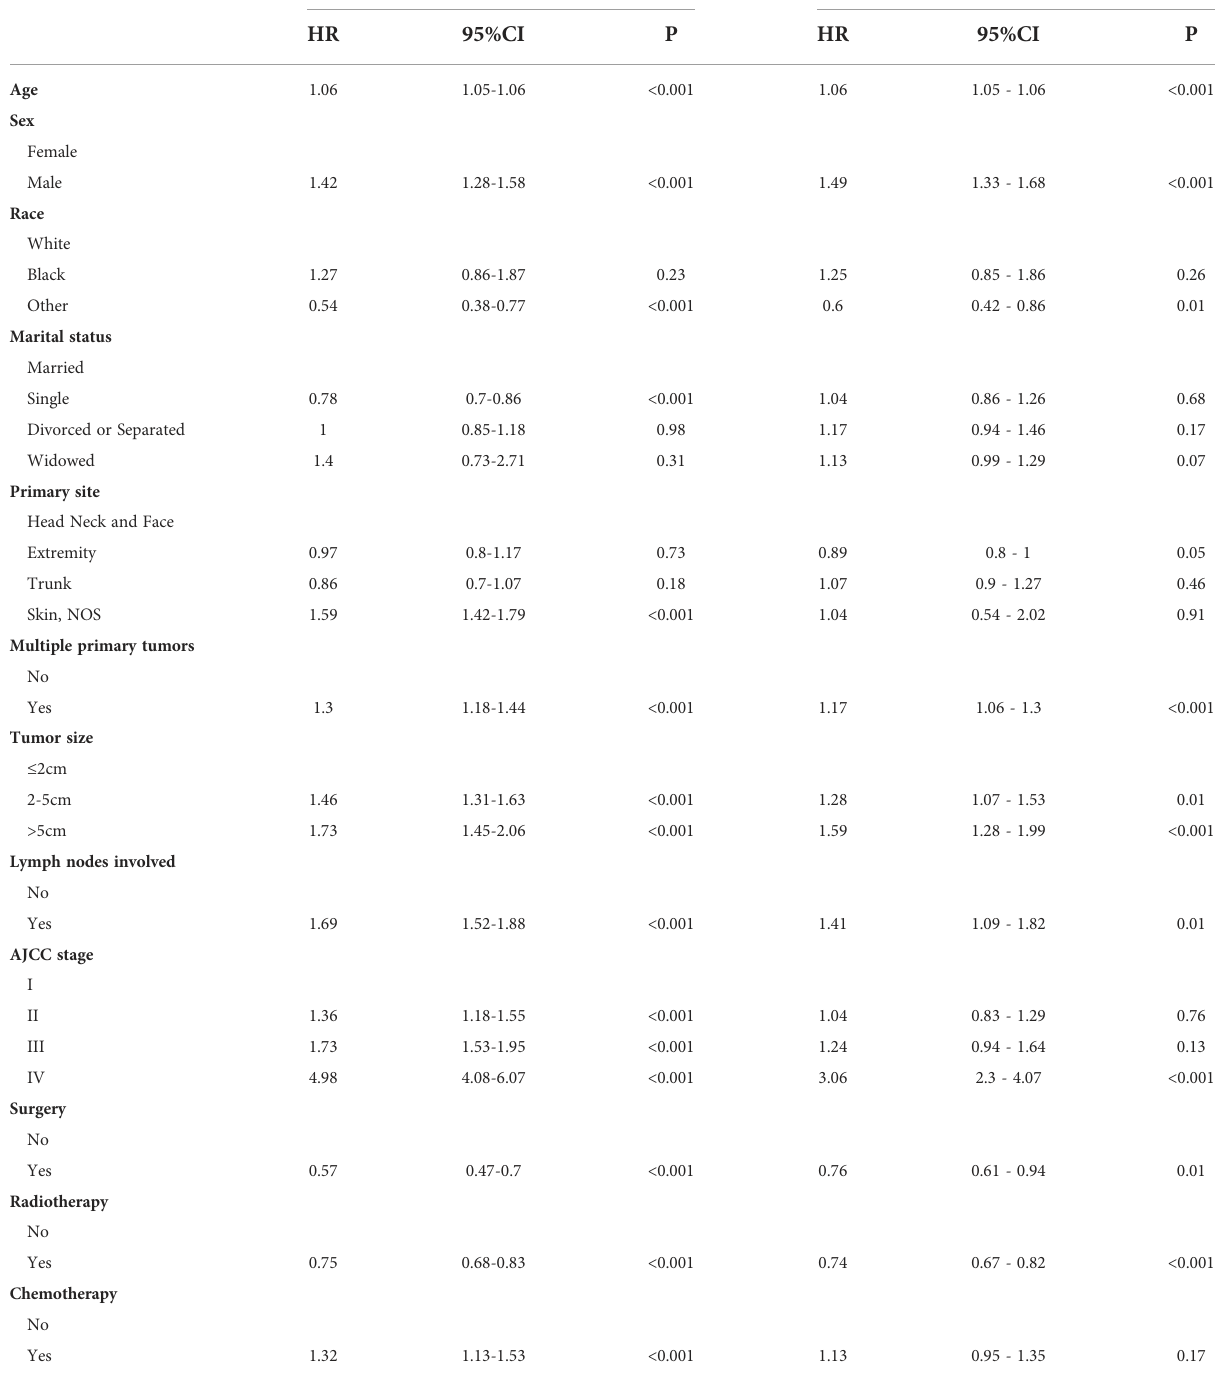
TABLE 2 Univariate and multivariate Cox regression analysis of OS. Univariate